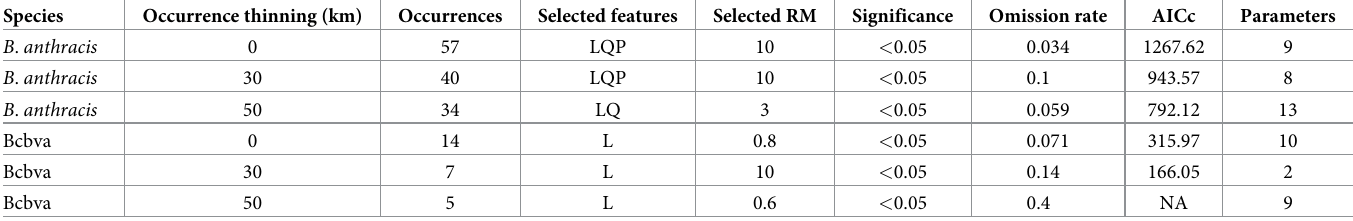
Table 1. Parametrization of selected Bacillus anthracis and Bcbva models. Parameters for models selected after a three-step selection framework (pROC, omission rates, and AICc), considering the different sets of occurrences and environments explored. Features: L = linear, LQ = linear + quadratic, LQP = linear + quadratic + prod- uct; RM: regularization multiplier; pROC: partial area under the Receiver Operating Characteristic; AICc: Akaike information criterion corrected for sample sizes. Species Occurrence thinning (km) Occurrences Selected features Selected RM Significance Omission rate AICc